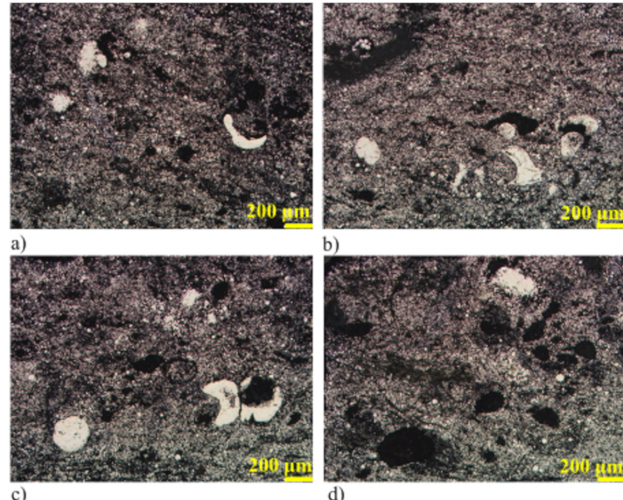
Figure 7. Photomicrographs under reflected light; ( a – d ) pyritic bioclasts (?).